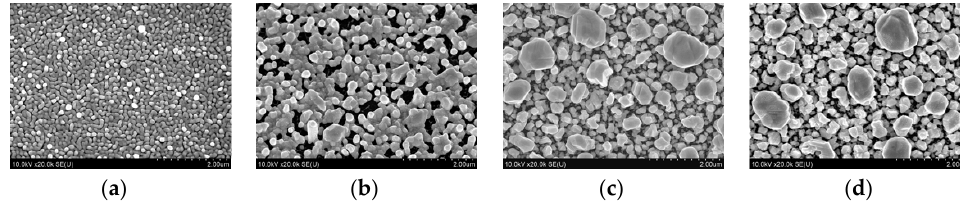
Figure 3. The SEM top views of ( a , b ) monocrystalline silicon and ( c , d ) mesoporous silicon coated with Ag NPs by immersion deposition. ( a , c ) as prepared samples, ( b , d ) samples kept in air at 21 °C for 3 months (provided by the authors).